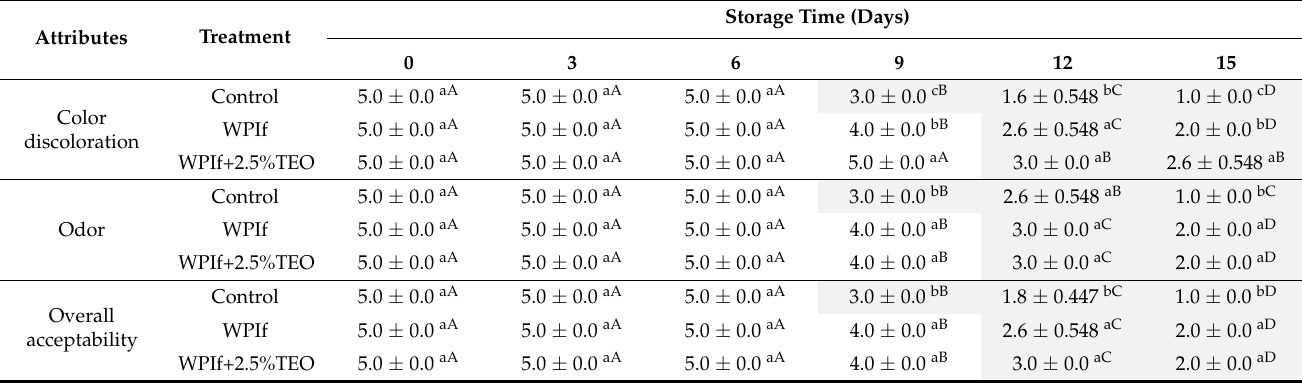
Table 2. Changes in sensory scores (points) of brook trout samples during refrigerated storage.